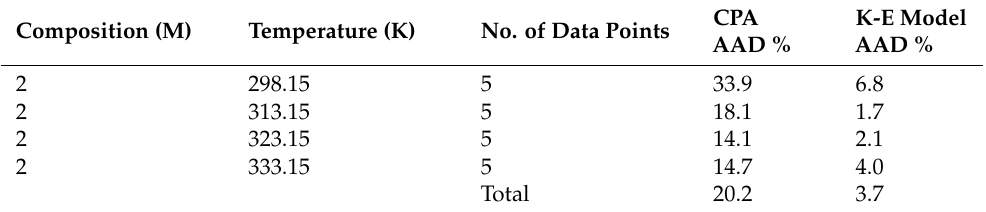
Table 10. Percentage average absolute deviations (AAD %) of models’ correlations form the experi- mental data of this study for the CO 2 loading of AMP solutions.